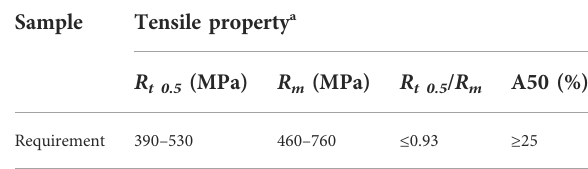
TABLE 2 Tensile mechanical properties of API5 L about X52 pipeline steel.